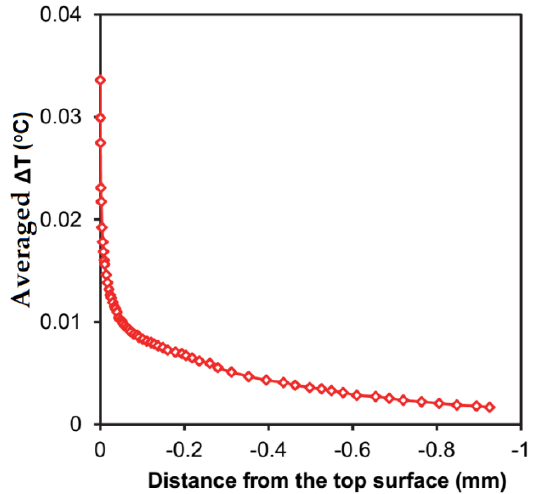
Figure 6. A typical variation of ∆ T from the top surface of the Silicon specimen down into the underneath material.